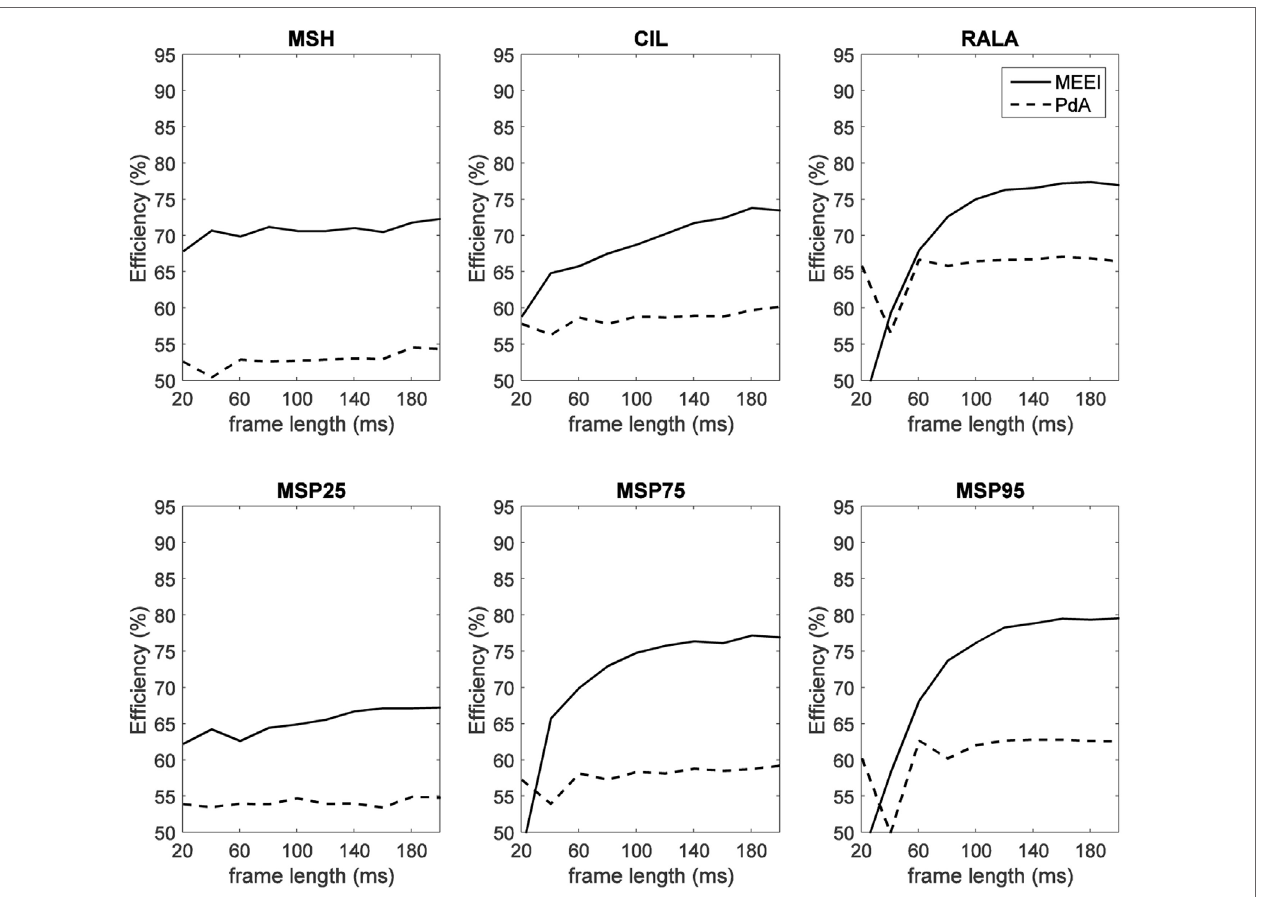
FigUre 5 | influence of frame length on efficiency for Meei (continuous) and PdA (dashed) databases